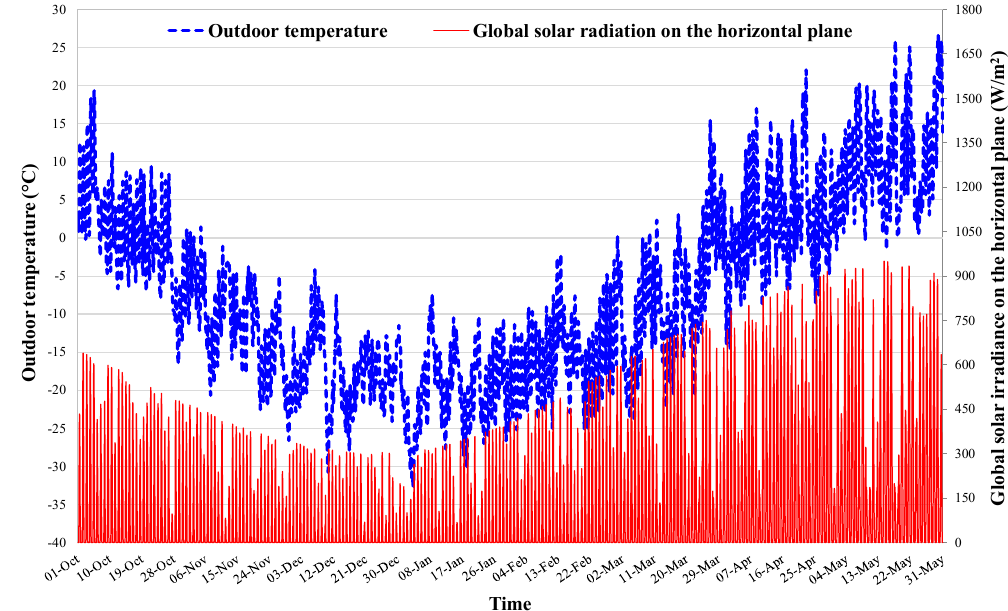
Figure 5. The outdoor temperature and global solar radiation on the horizontal plane during the heating season in Ulaanbaatar [39].